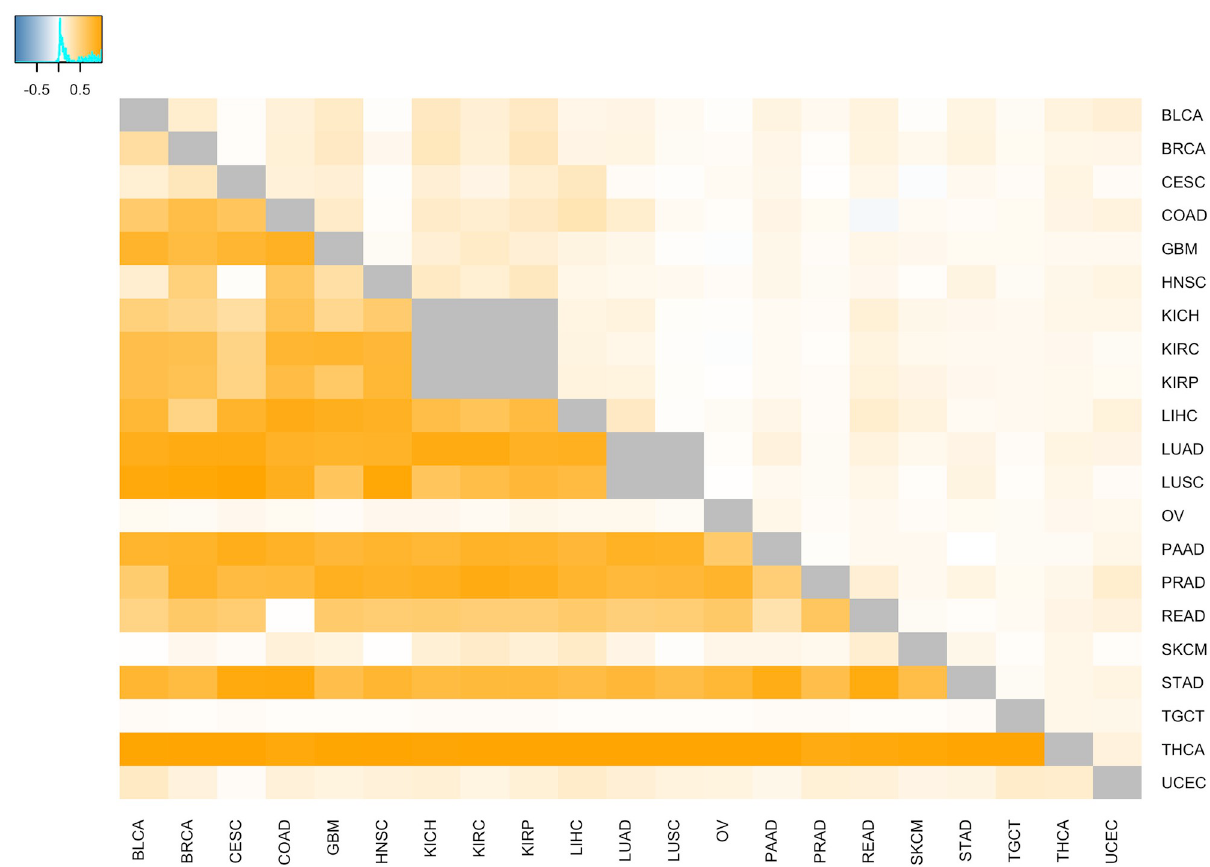
Fig 4. Impact of normal tissue-specificity on cancer differential expression. Cell coloring reflects the Pearson correlation between the fold-change in gene expression between each pair of cancers and the corresponding pair of normal tissues. Large correlations indicate that the expression difference between cancers mirrors the expression difference in the normal tissues. For cells below the diagonal, all genes are used to compute the correlations; for cells above the diagonal, genes that have a fold-change between normal tissues of � 0.5 or � 2 are excluded. As indicated by the lower correlations in cells above the diagonal, filtering out genes that show large differential expression between normal tissues will generate cancer differential expression results that are distinct from the normal tissue biology.